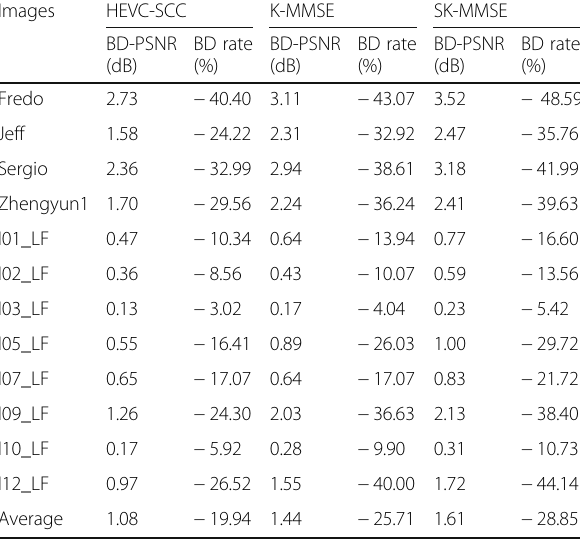
Table 2 Y-rate-distortion gains of three coding methods over HEVC